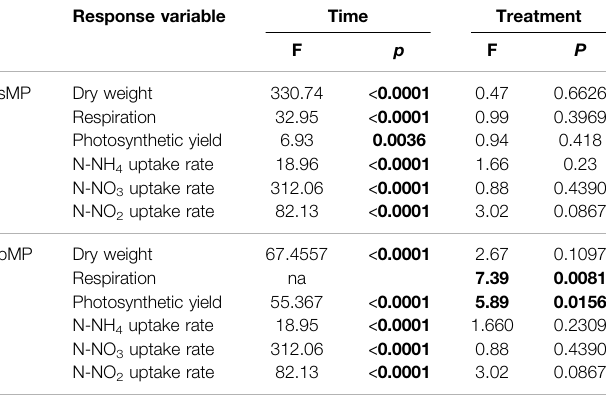
TABLE 3 | Statistical results from mixed effects analysis with dry weight, respiration, photosynthetic yield, and nutrient uptake rates as dependent variable and experimental time and treatment as fi xed variables. p values < 0.05 in bold type indicate signi fi cant differences over time or among treatments. Calculations were carried out using the nlme package in R version